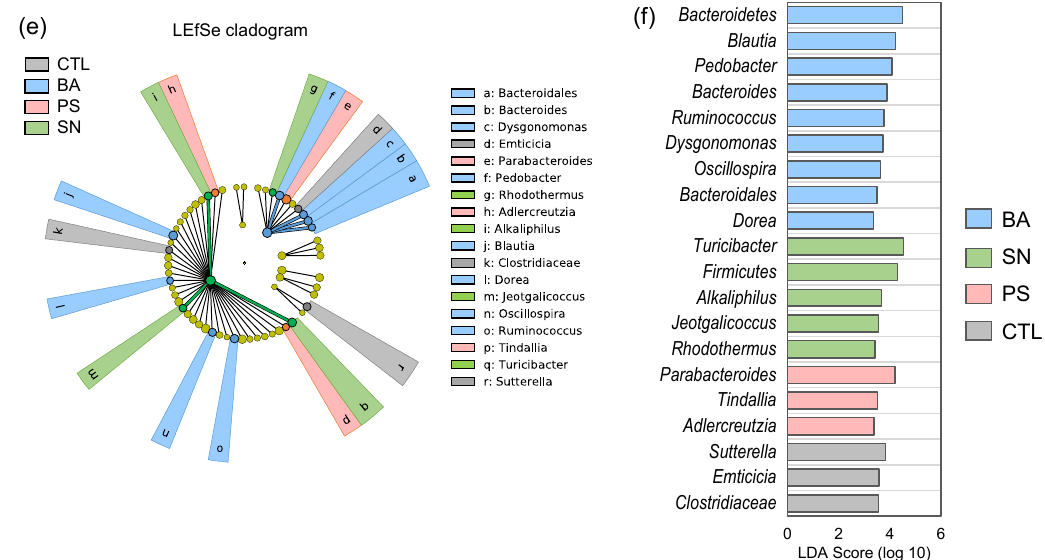
Figure 3. Specific microbiota signatures in mice consuming different preservatives. ( a − d ) The random forest graph shows the most predictive bacterial phyla, orders, families, and genera influenced by the intake of specific preservatives. ( e , f ) Linear discriminatory analysis (LDA) effect size (LEfSe) cladogram ( e ) and LDA bar plot ( f ) representing the bacterial taxa significantly unique in mice consuming benzoate (BA), potassium sorbate (PS), or sodium nitrite (SN) versus control (CTL) mice.